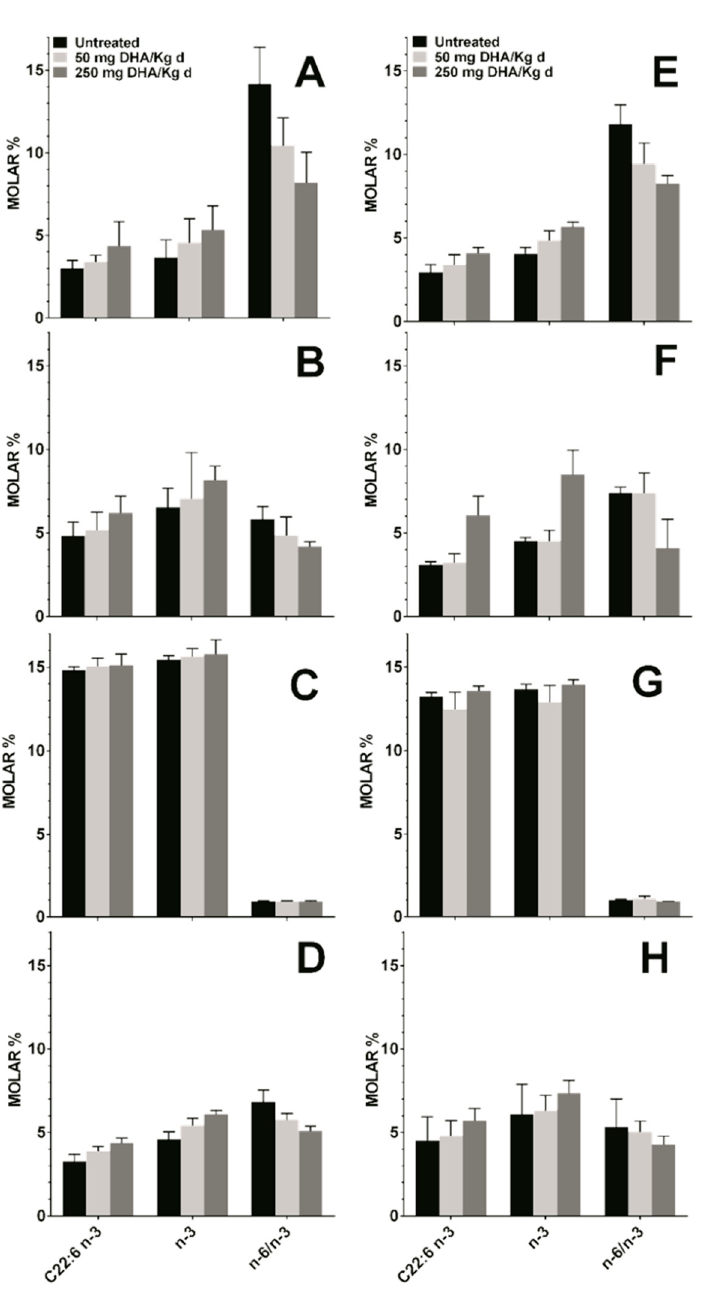
Figure 5. Concentration in molar % of different fatty acid in plasma ( A , E ), RBC membrane ( B , F ), brain ( C , G ), and spleen ( D , H ) in healthy mice ( A , B , C , D ) and in the EAE mice model ( E , F , G , H ) untreated (black bars) and treated with DHA at 50 (light gray bars) or 250 mg/kg/day (dark grey bars). C22:6 n -3, DHA; n -3, omega-3 fatty acids; n -6/ n -3, omega-6 to omega-3 fatty acid